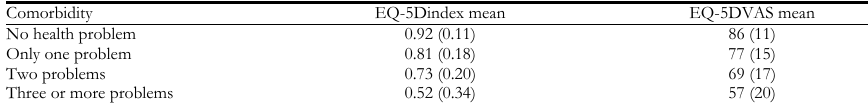
EQ-5D index mean and VAS mean for